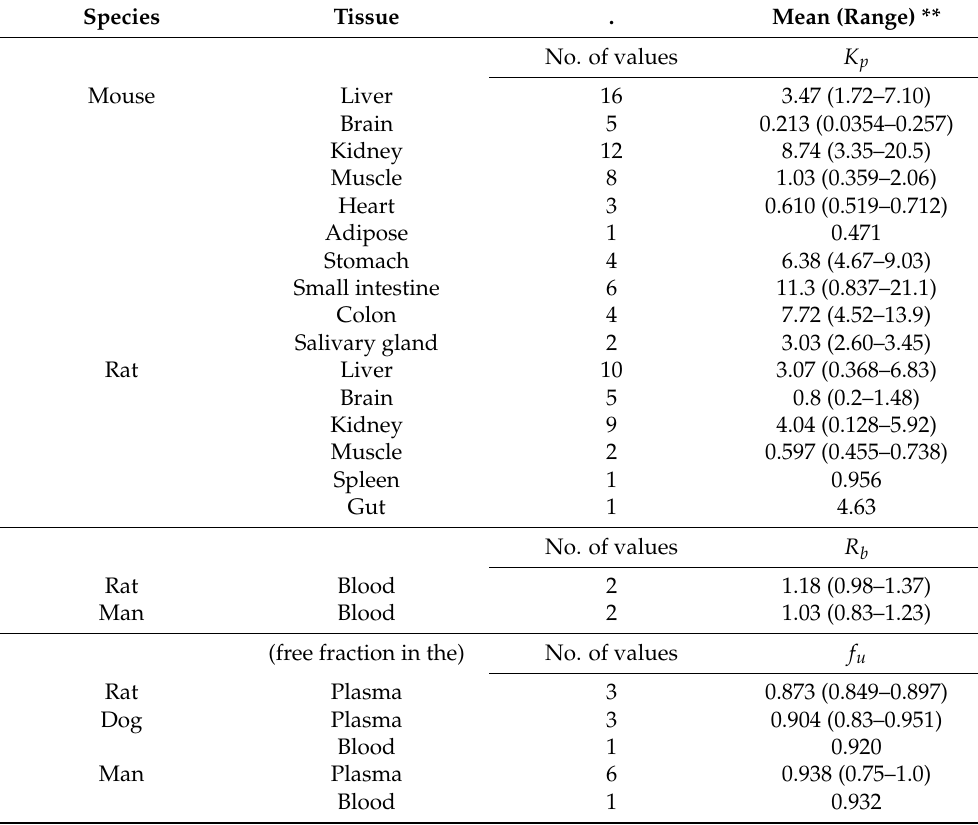
Table 6. Summary of measured tissue and blood partition coefficients in four species